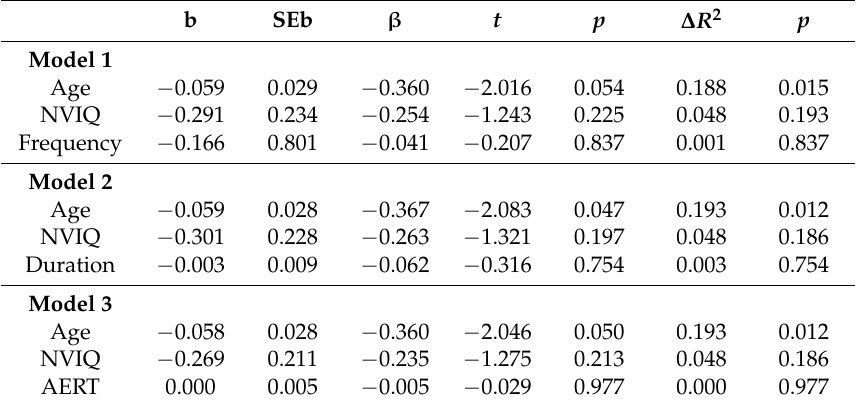
Table 8. Stepwise regressions showing the unique variance in children’s response time in judging metrical and syntactic boundaries contributed by the different auditory processing measures. b SEb